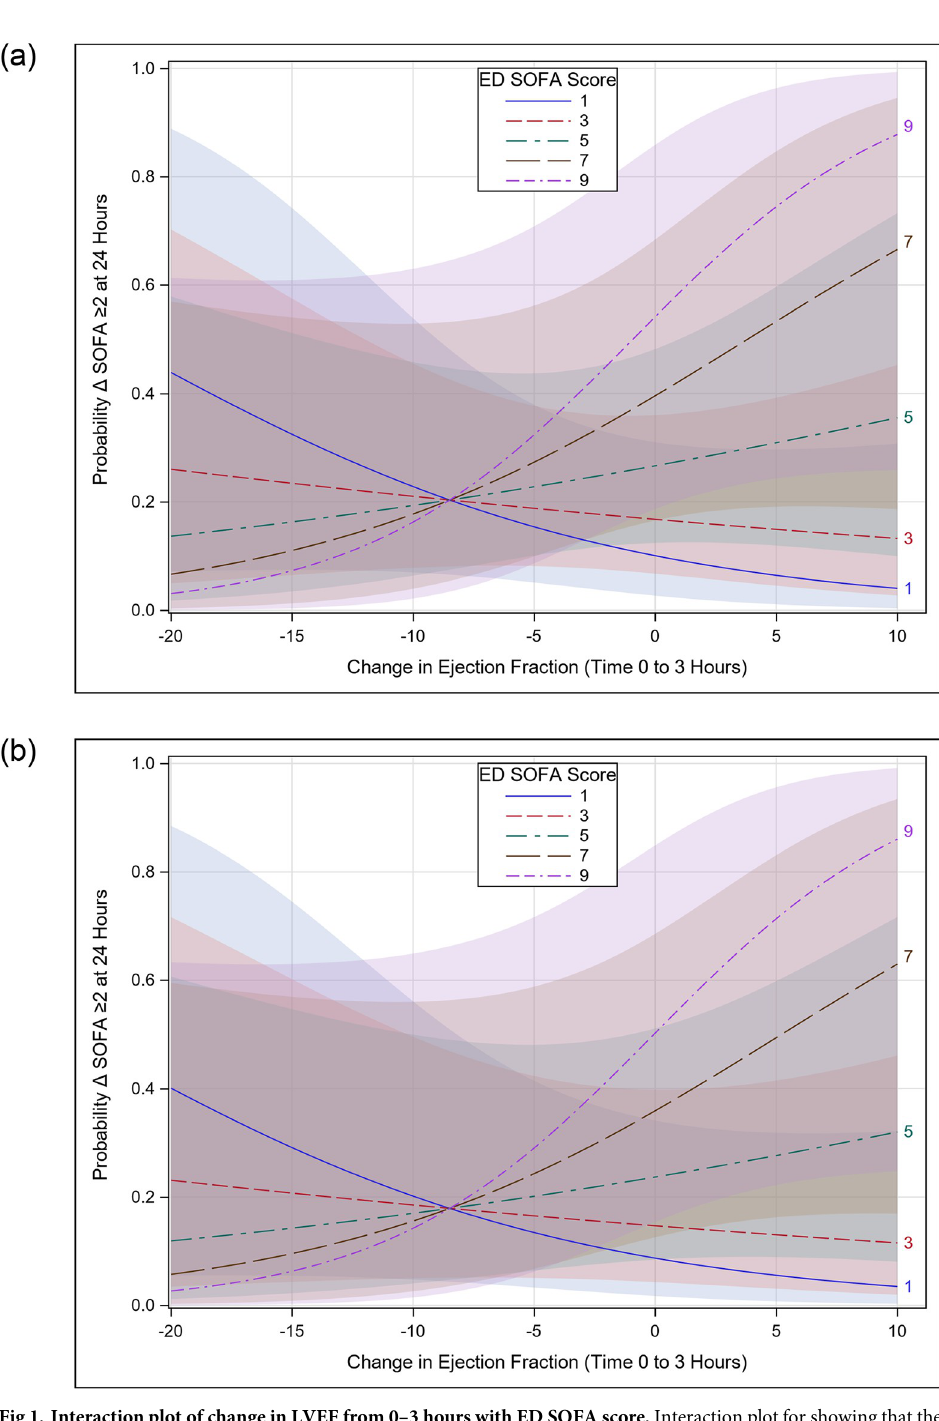
Fig 1. Interaction plot of change in LVEF from 0–3 hours with ED SOFA score. Interaction plot for showing that the influence of change in left ventricular ejection fraction on the probability of meeting the outcome of Δ SOFA � 2 at 24 hours varies by baseline (ED) SOFA Score, adjusted for baseline inferior vena cava (IVC) collapsibility; bands represent 95% CIs. Panel A represents patients with IVC collapse � 50%; Panel B represents patients with IVC collapse < 50%.